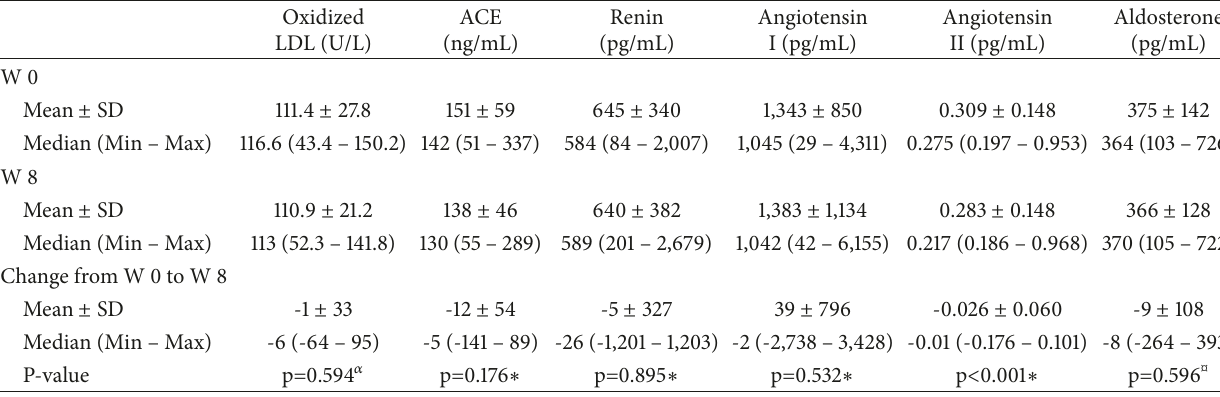
Table 5: Results from Exploratory Analyses for Participants in the RPC